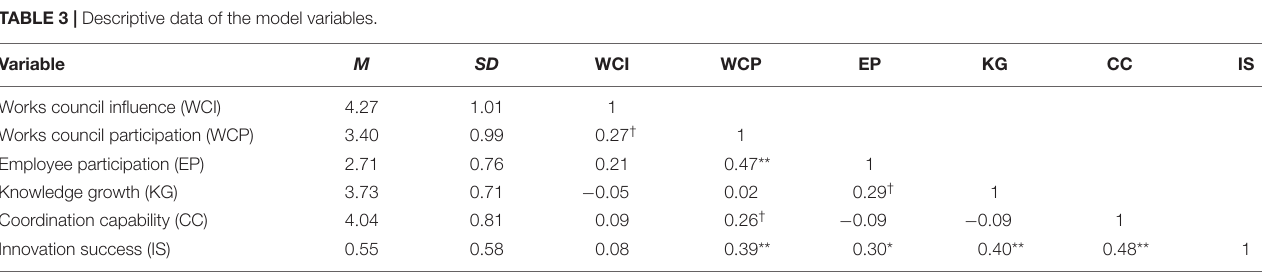
TABLE 3 | Descriptive data of the model